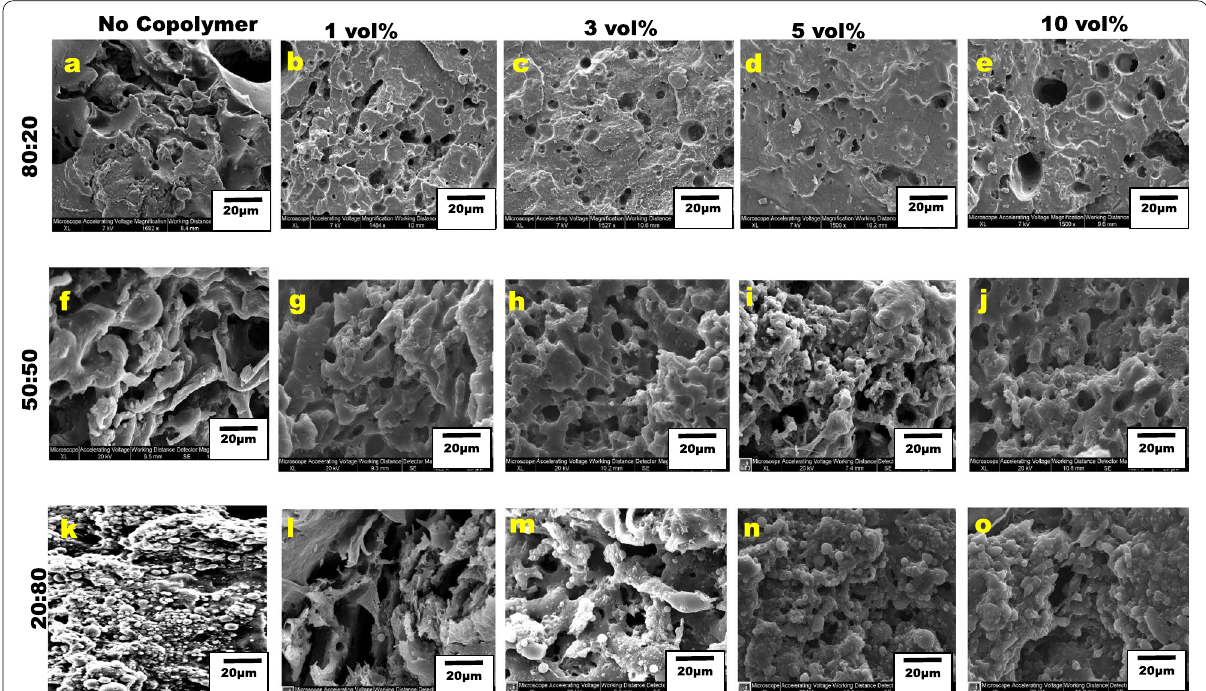
Fig. 3 SEM micrographs of PP/PS/ 2 vol% MWCNT/ SEBS triblock copolymer. From left to right, the triblock copolymer concentration increases and from top to bottom, PS amount increases in the blend composition. PS phase was extracted in all the composites using THF